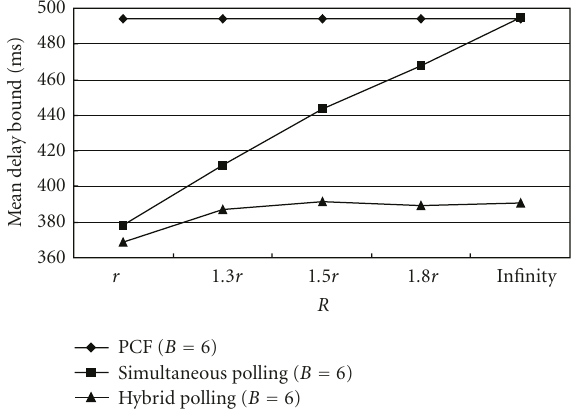
Figure 10: Mean delay bounds when the light tra ffi c load ( B = 4) is imposed on IEEE 802.11a wireless LAN with 40 STAs.